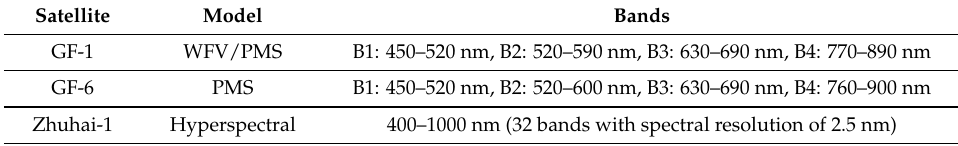
Table 2. The spectral bands of GF-1, GF-1D, GF-6 and Zhuhai-1 hyperspectral used in this study.